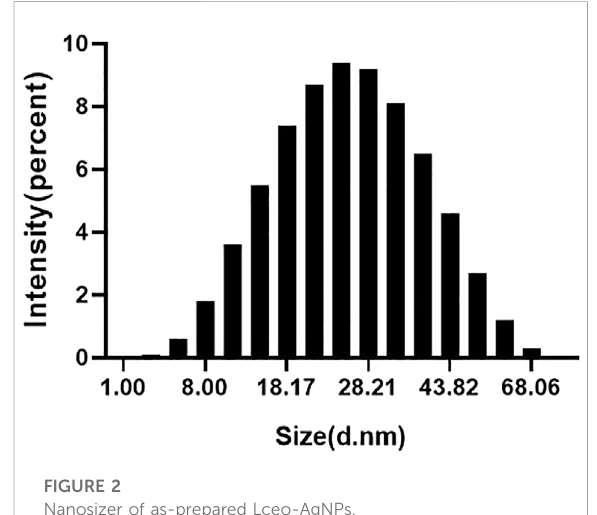
FIGURE 2 Nanosizer of as-prepared Lceo-AgNPs.